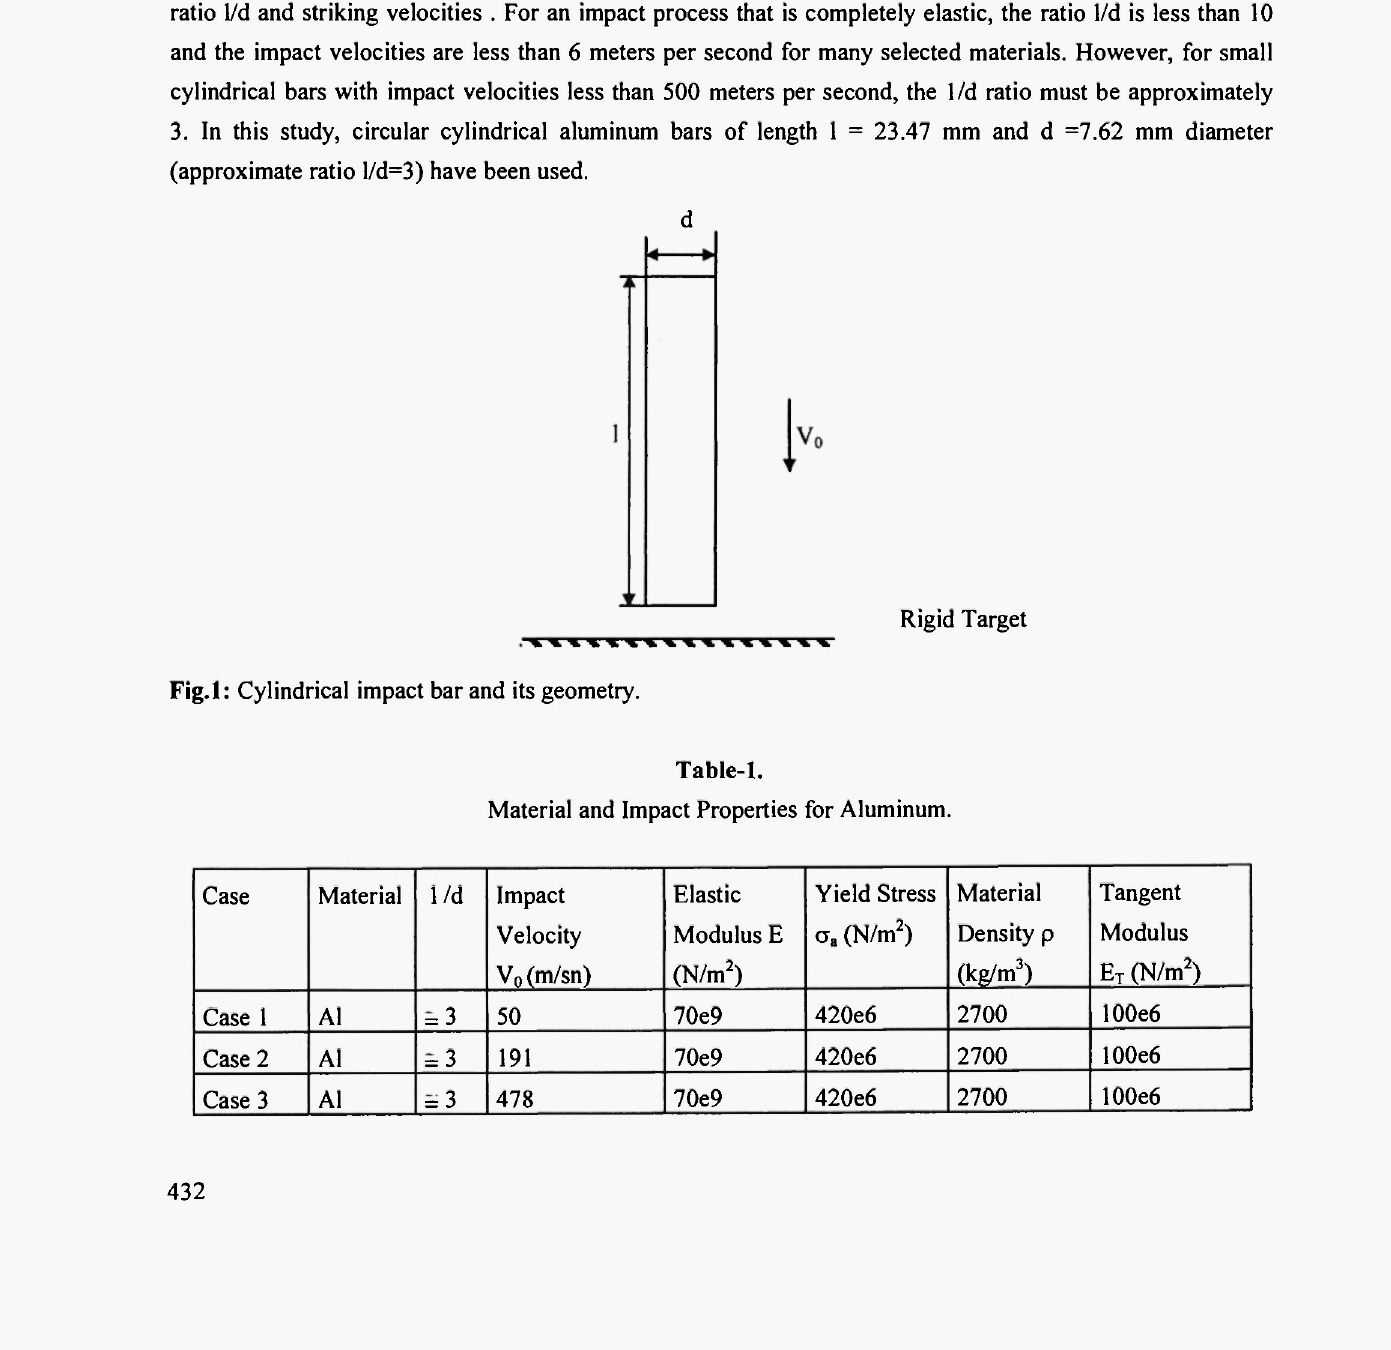
Material and Impact Properties for